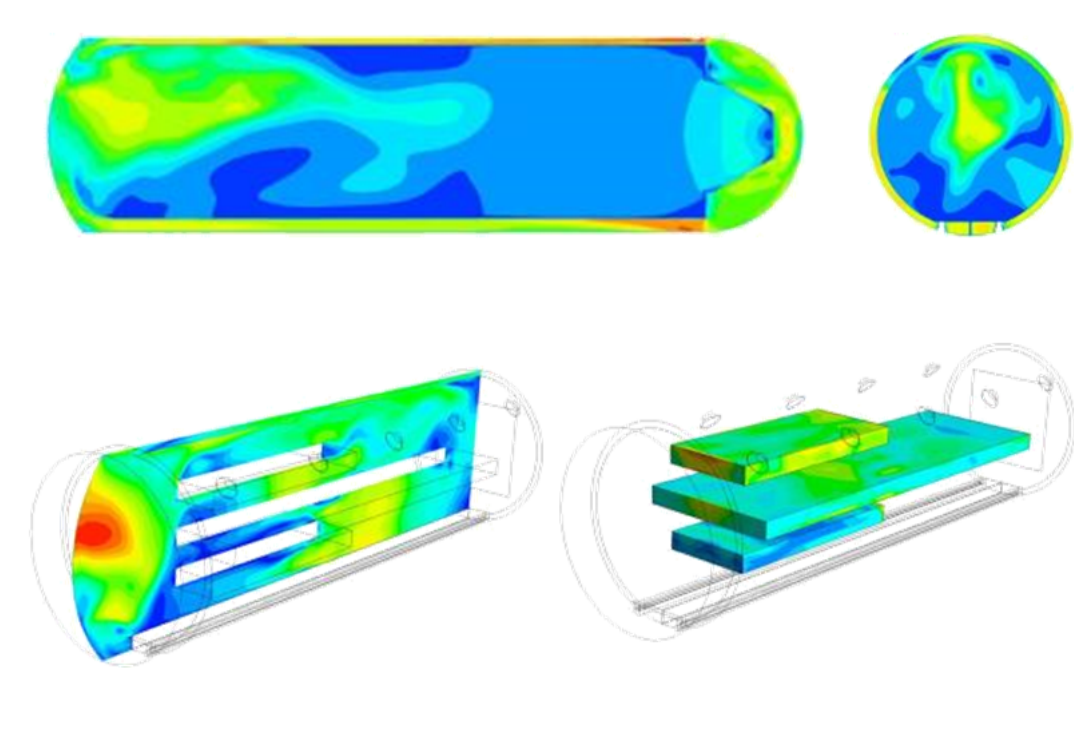
Figure 6: Virtual Autoclave - CFD and curing